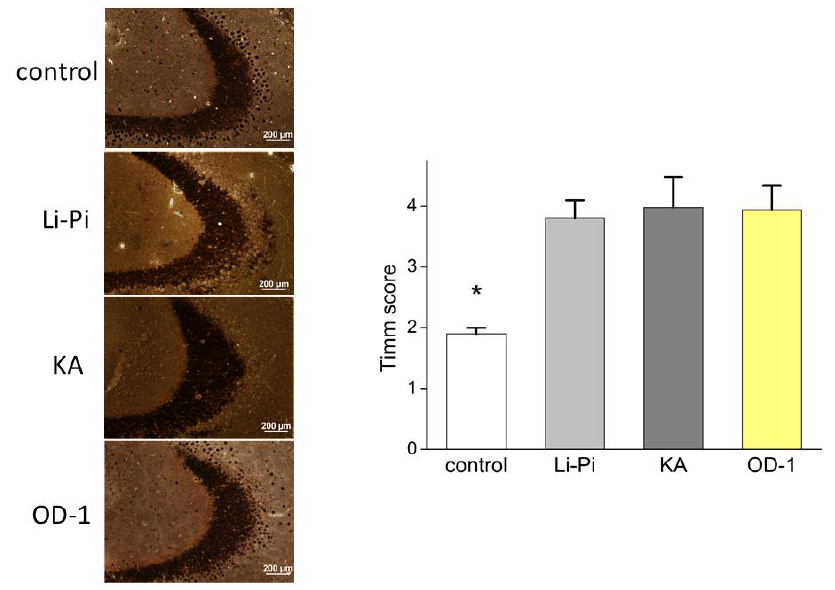
Figure 7. There were similar amounts of cresyl violet stained neurons in the Li-Pi, KA, and OD-1 models. Scale bar = 200 μm. The semiquantitative neuronal damage scores were similar across the three groups ( p = 0.20) although the OD-1 group had a slightly higher overall score. The naïve control (1.9 ± 0.1) showed significantly less damage than the other three groups (* p < 0.05). Data were analyzed using an ANOVA Kruskal–Wallis H test followed by Dunn’s multiple comparison tests ( n = 7 in each group).